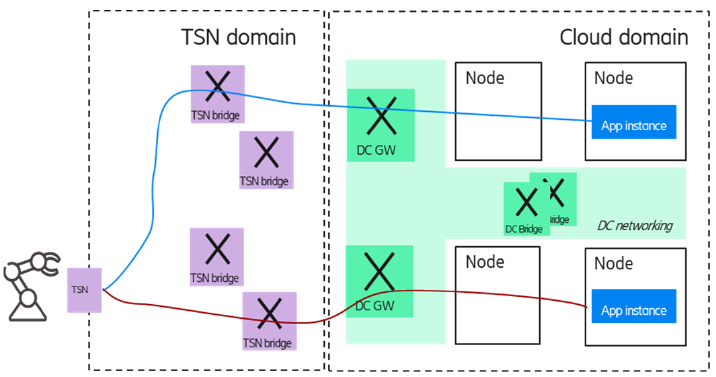
Figure 9. Robustness provided by per-application instance TSN streams using different transport and cloud resources.